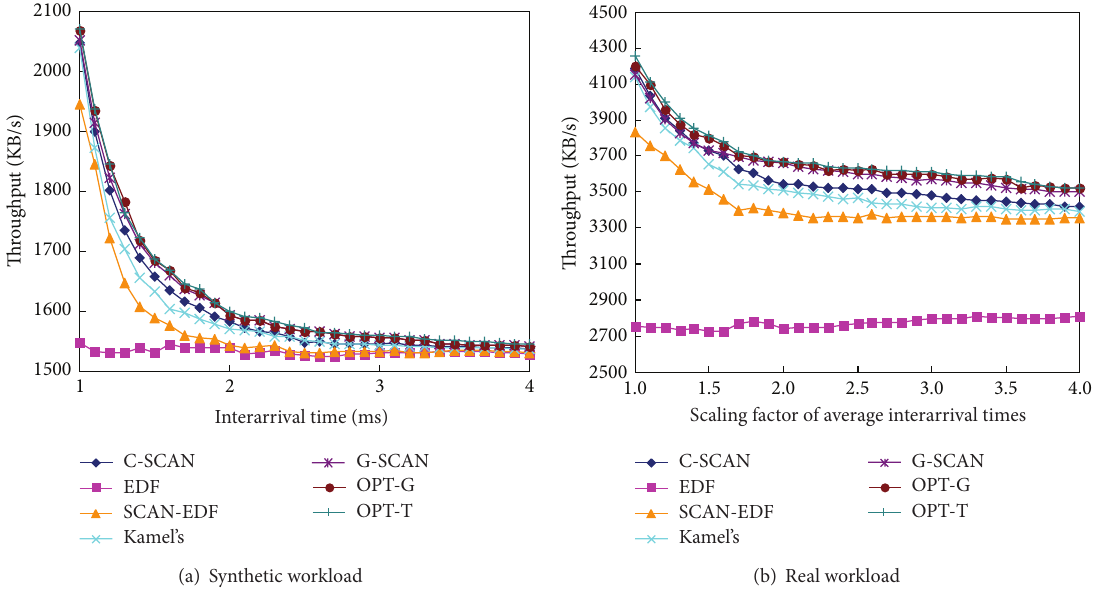
Figure 7: Throughput of the algorithms as a function of workload